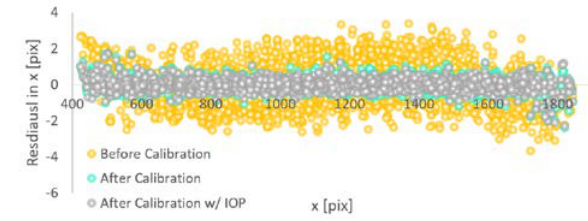
Figure 5: x-image residuals as a function of their column number in the image